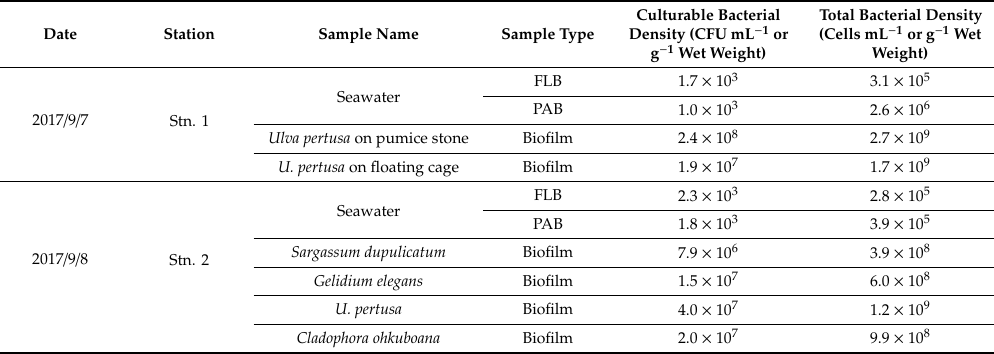
Table 1. Summary of culturable and total bacterial densities enumerated from seawater and